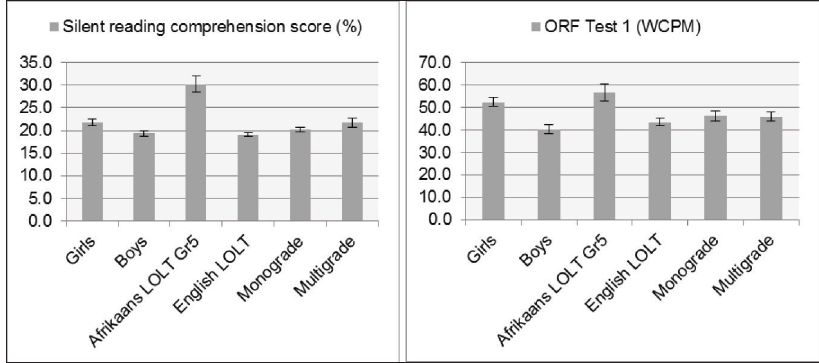
Figure 1: Average silent reading comprehension score (%) and ORF 1 score (WCPM) by gender and grade